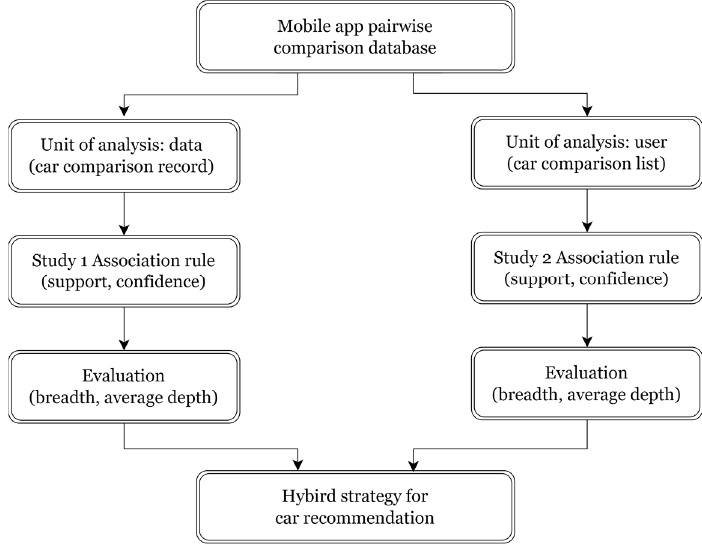
Figure 1. Recommender system based on pairwise comparison data.